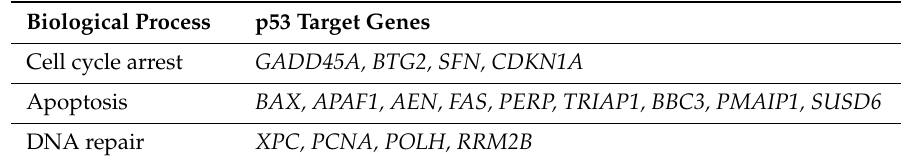
Table 1. A few p53 target genes in cell cycle arrest, apoptosis, and DNA repair (a complete list can be found in